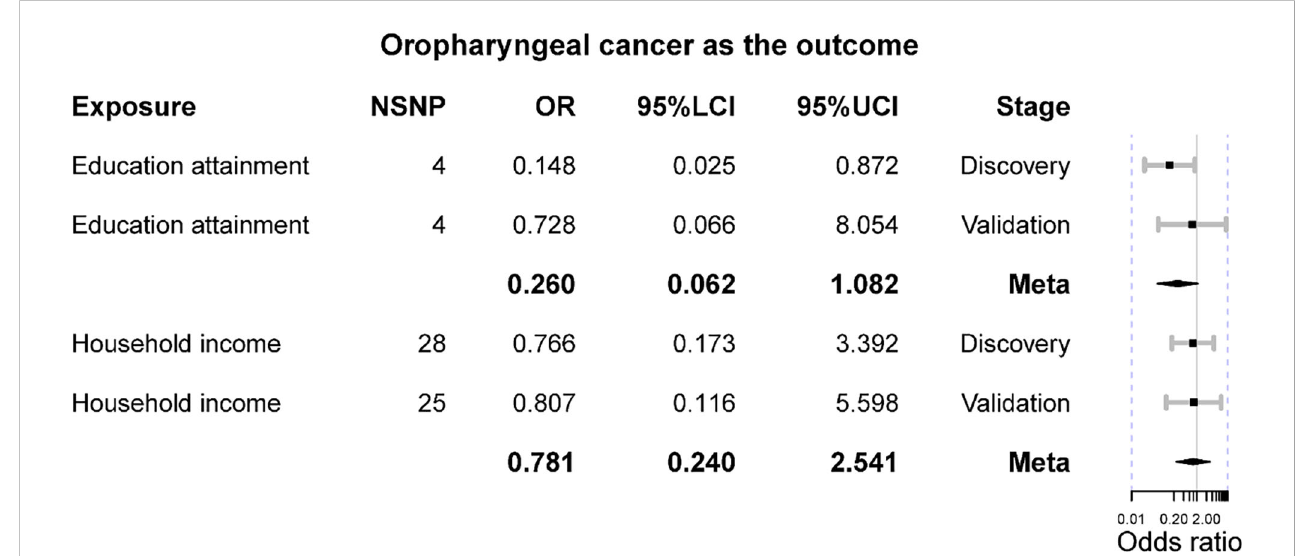
FIGURE 2 The Mendelian randomization results of educational attainment and household income on oropharyngeal cancer. OR is the odds ratio; 95%LCI is the lower limit of 95% con fi dence interval; 95%UCI is the lower limit of 95% con fi dence